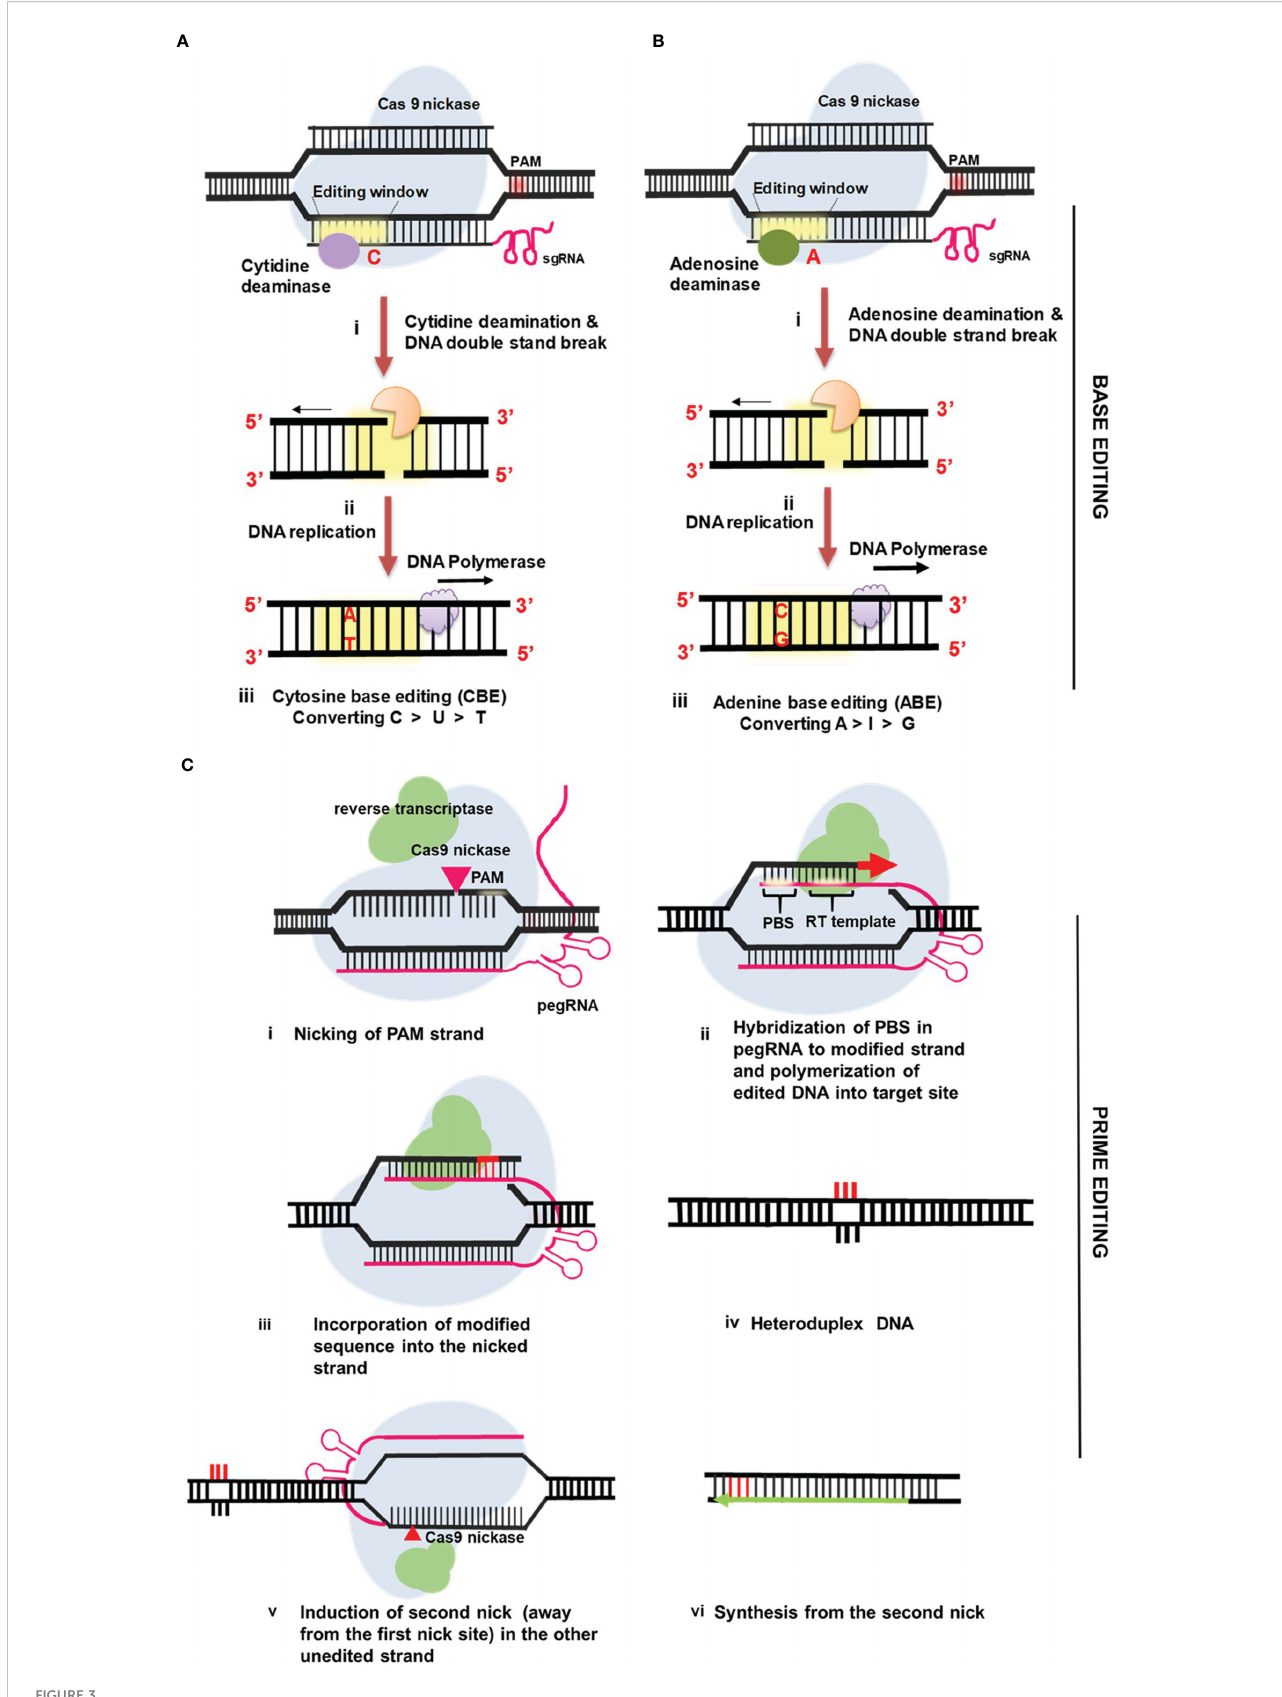
FIGURE 3 Mechanism of precise genome editing in plants using base editors and prime editors (A) Cytosine Base Editing (CBE) (B) Adenine Base Editing (ABE) (C) Prime Editing